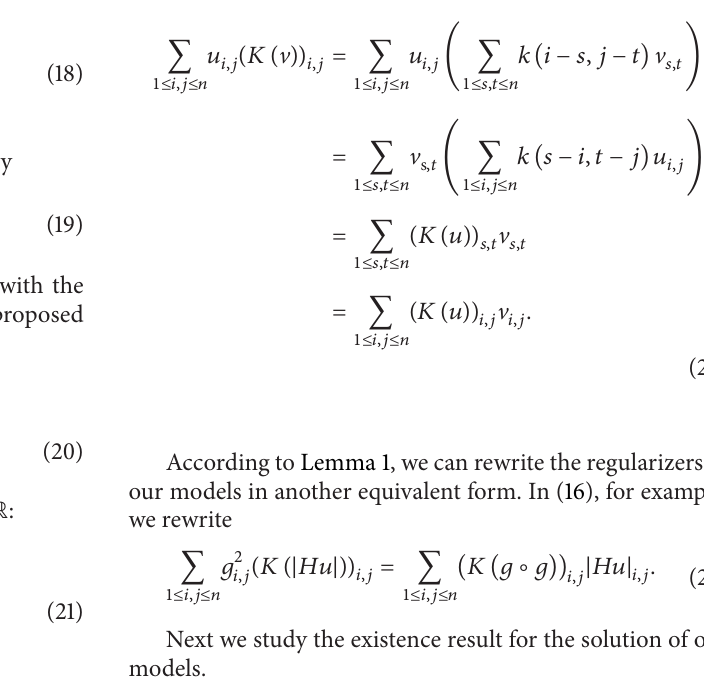
centered at pixel (𝑖, 𝑗) (with a periodic extension at the boundary); that